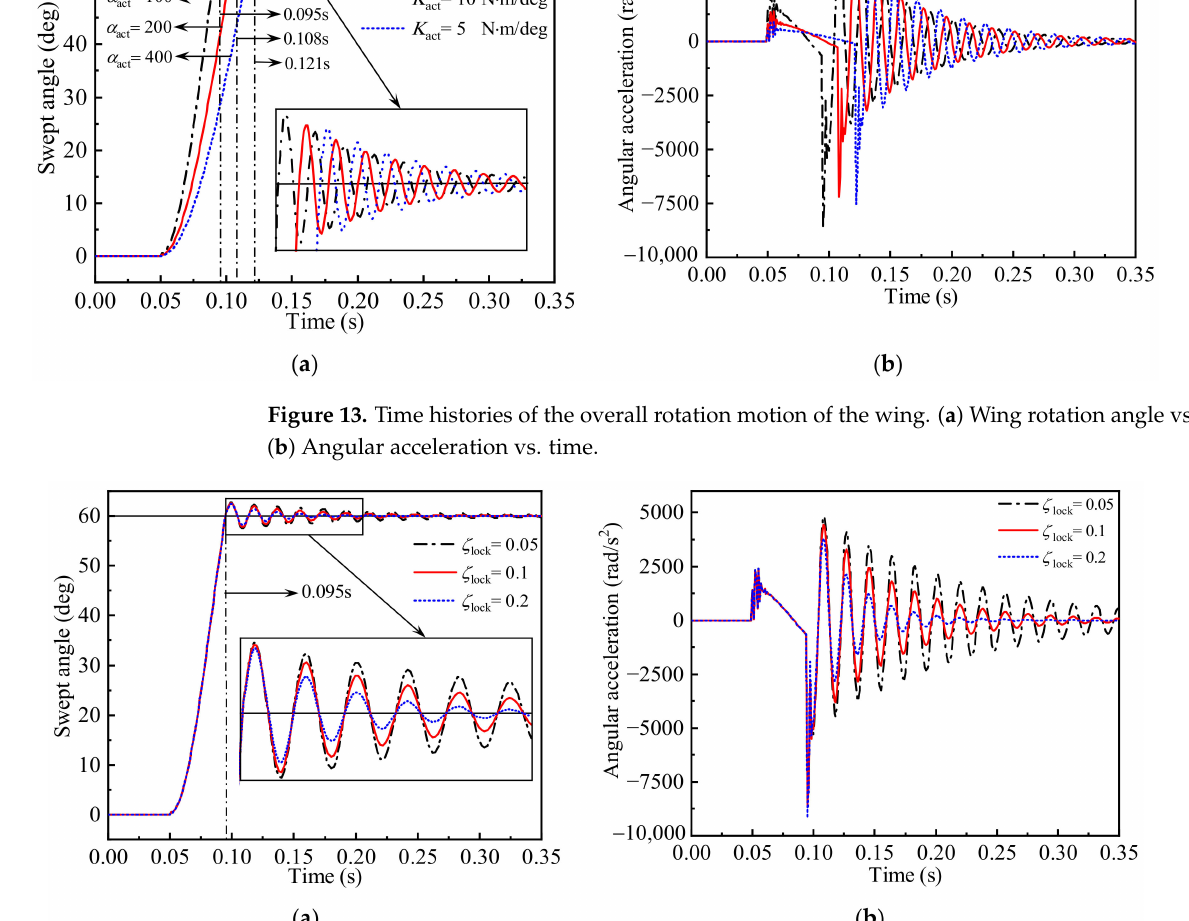
Figure 14. Time histories of the rotation motion of the wing. ( a ) Wing rotation angle vs. time. ( b ) Angular acceleration vs.